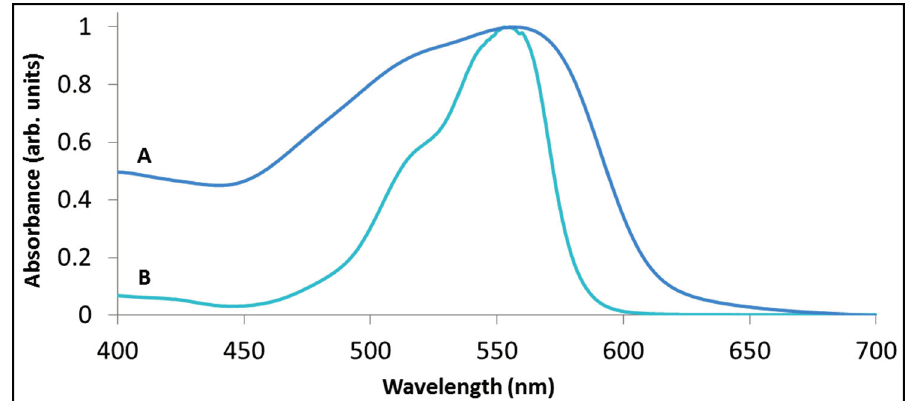
Figure 5. The absorption spectrum of rhodamine B (A) adsorbed on BiOCl (B) in aqueous solution. It is noteworthy however that using the spectrum of the adsorbed dye as a source for correlation with the action spectrum still does not guarantee a high fidelity correlation. Figure 6 presents the decolorization rate constants obtained from a series of photoinduced degradation measurements of RhB (concentration: 6 mg/L) in the presence of BiOCl. Each data point represents exposure to light having a specific wavelength. The two data points at k = 0.1 sec − 1 and k = 0.11 sec − 1 represent exposure to photons in the